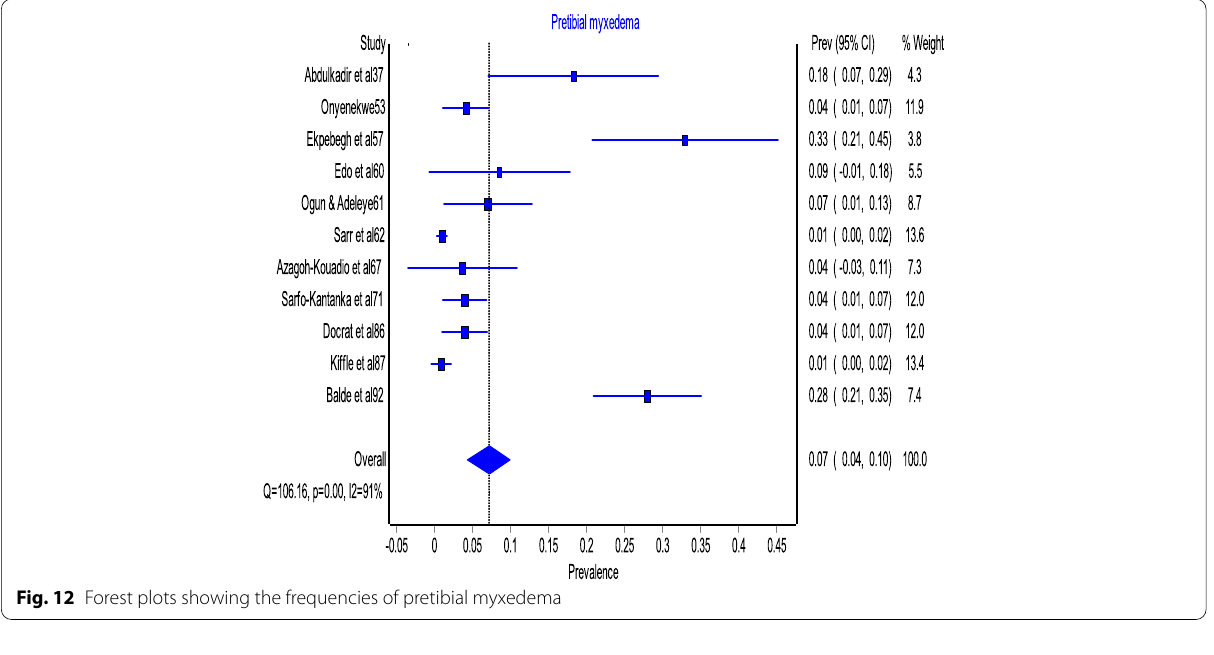
Fig. 12 Forest plots showing the frequencies of pretibial myxedema